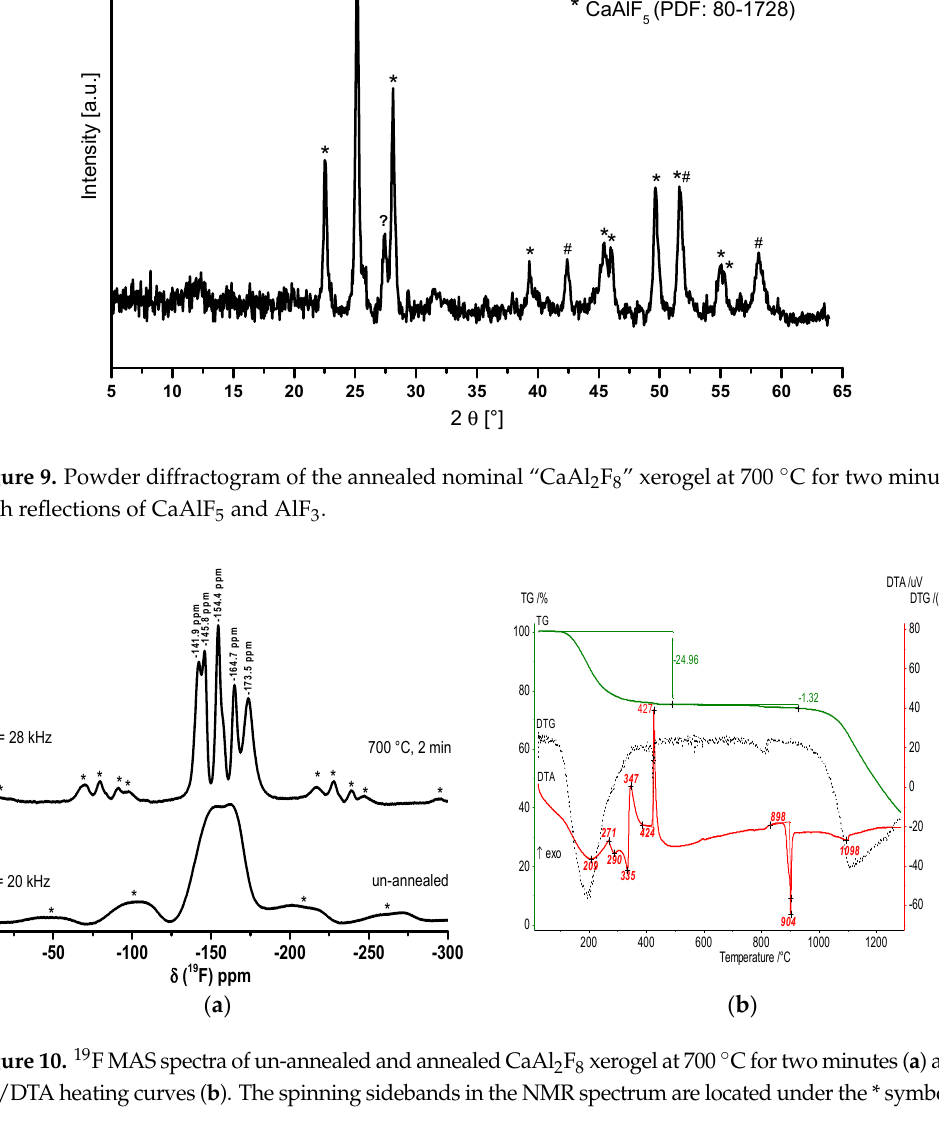
Figure 9. Powder diffractogram of the annealed nominal “CaAl 2 F 8 ” xerogel at 700 ° C for two minutes with reflections of CaAlF 5 and AlF 3 .